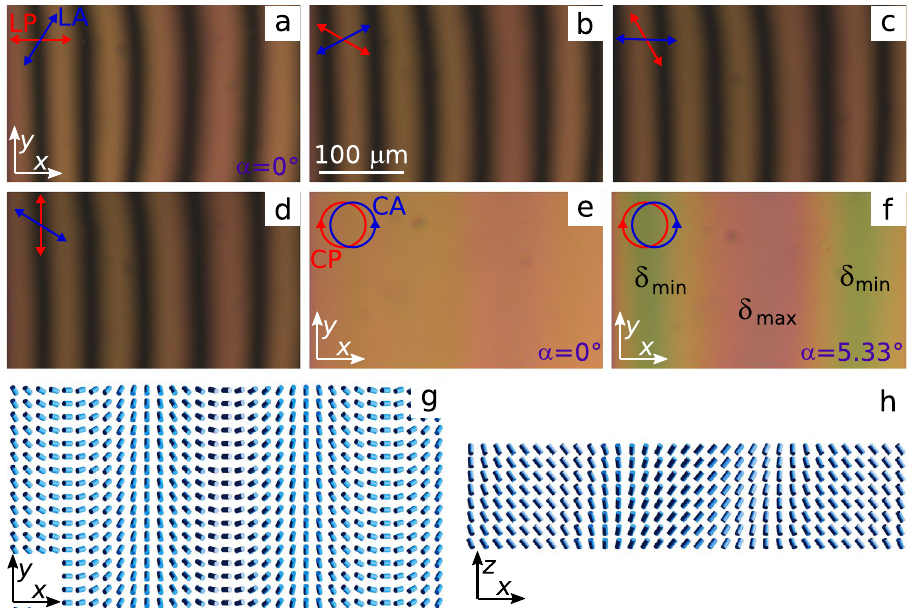
Figure 8. POM photos of the sample area of chiral nematic taken in the crossed at angle 58 ◦ LP and LA at the polariser orientation 0 ◦ ( a ), − 30 ◦ ( b ), − 60 ◦ ( c ), − 90 ◦ ( d ), and in the crossed circular polarisers at the light incidence angle α = 0 ◦ ( e ) and α = 5.33 ◦ ( f ). The corresponding director field at the bottom substrate ( g ) and in the cross-section of LC layer ( h